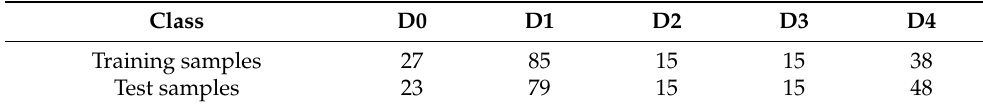
Table 1. Number of emission profiles per class using a random separation into training samples and test samples.